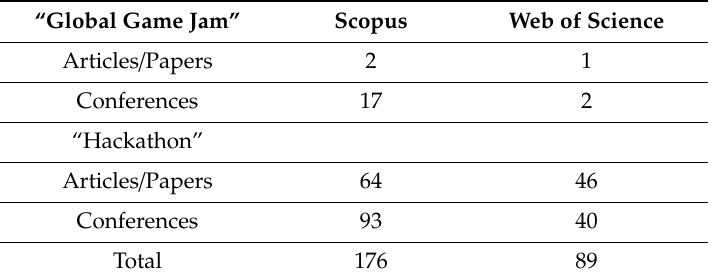
Table 1. Global Game Jam in international